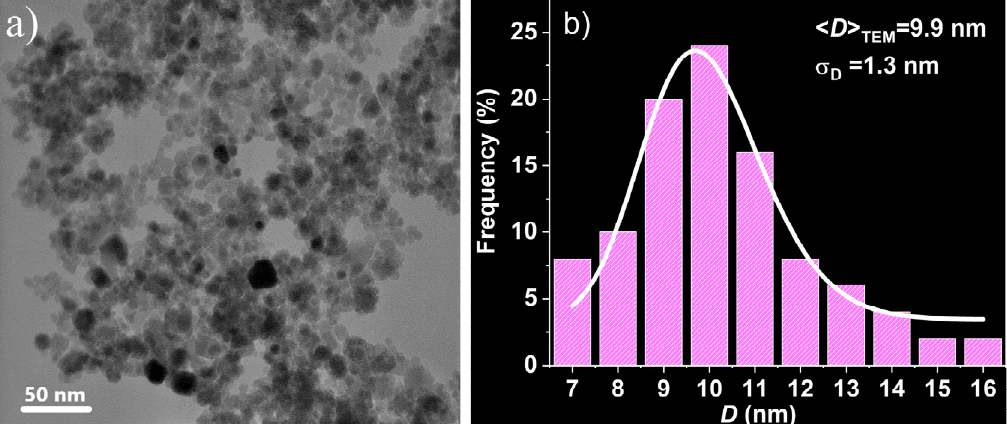
Fig. 5. (a) TEM image of Fe